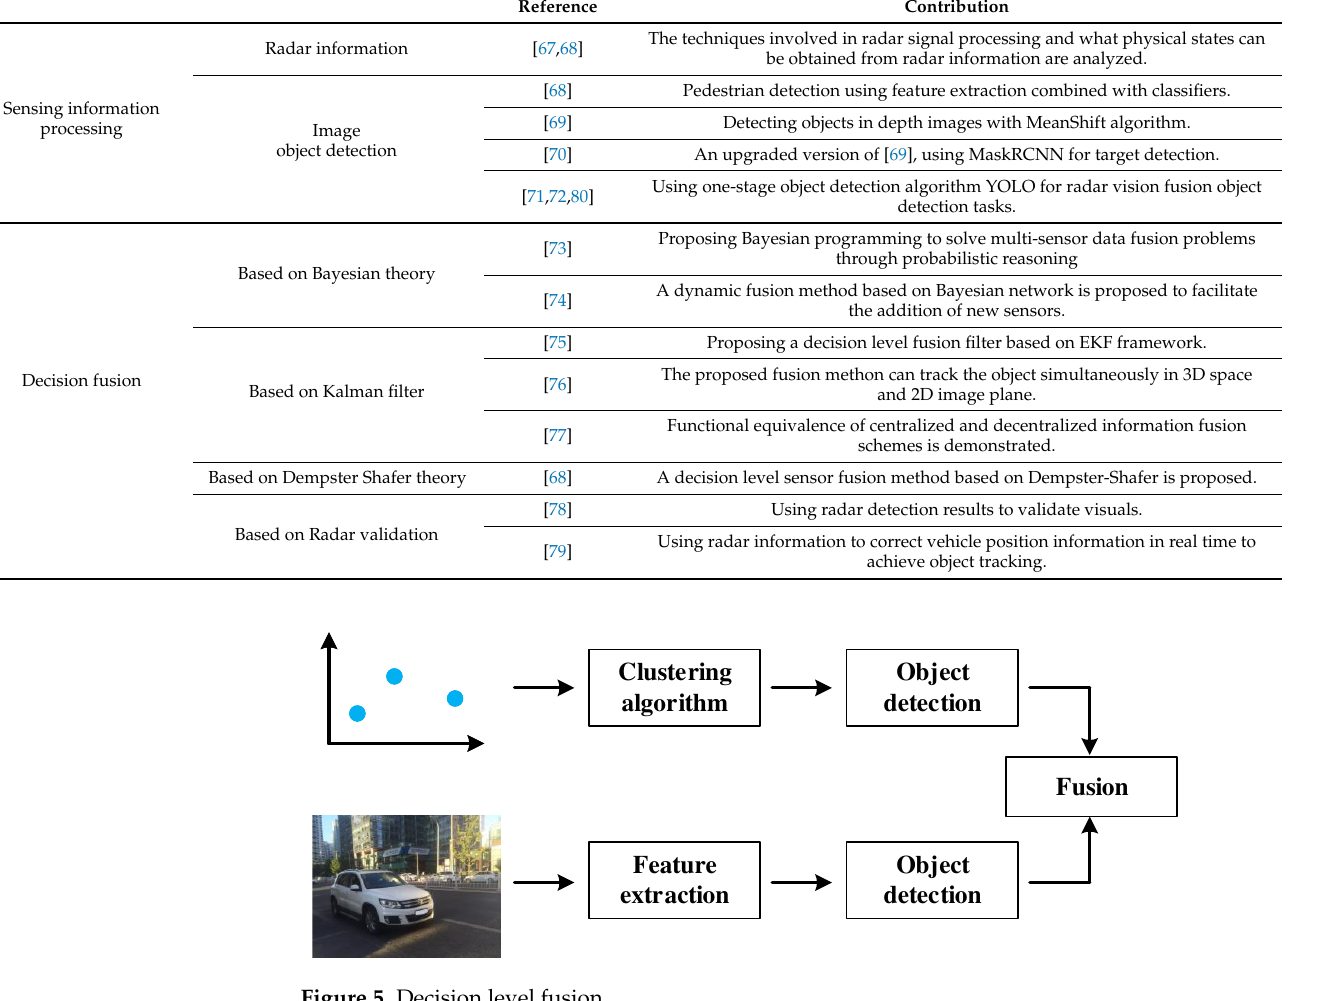
Figure 5. Decision level